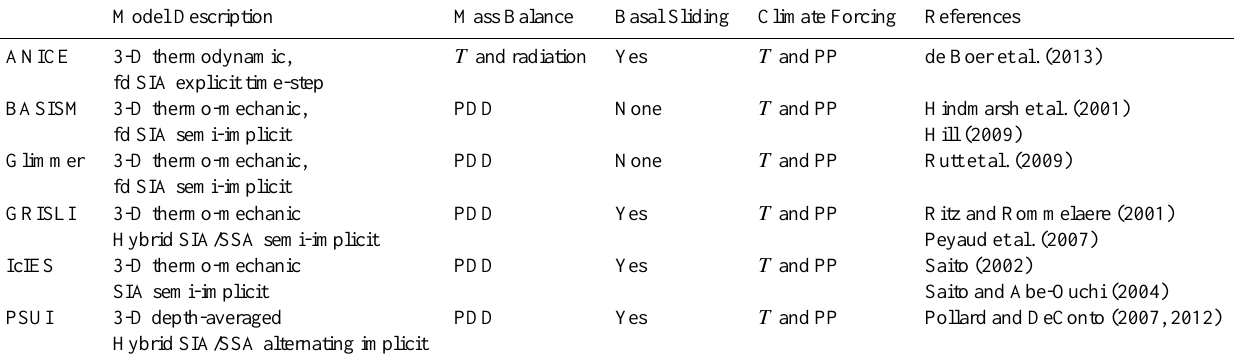
Table 3. Ice sheet model description table showing the resolution used in PLISMIP experiments, the mass balance method, whether there is basal sliding in the model, and how the model uses the climatological forcing. All models apply the climatological forcing with absolute val- ues of temperatures ( T ) and precipitation (PP), except Glimmer, and are run on a resolution of 20 × 20km. SIA is shallow ice approximation, SSA is shallow shelf approximation, PDD is positive degree-day scheme, fd is finite